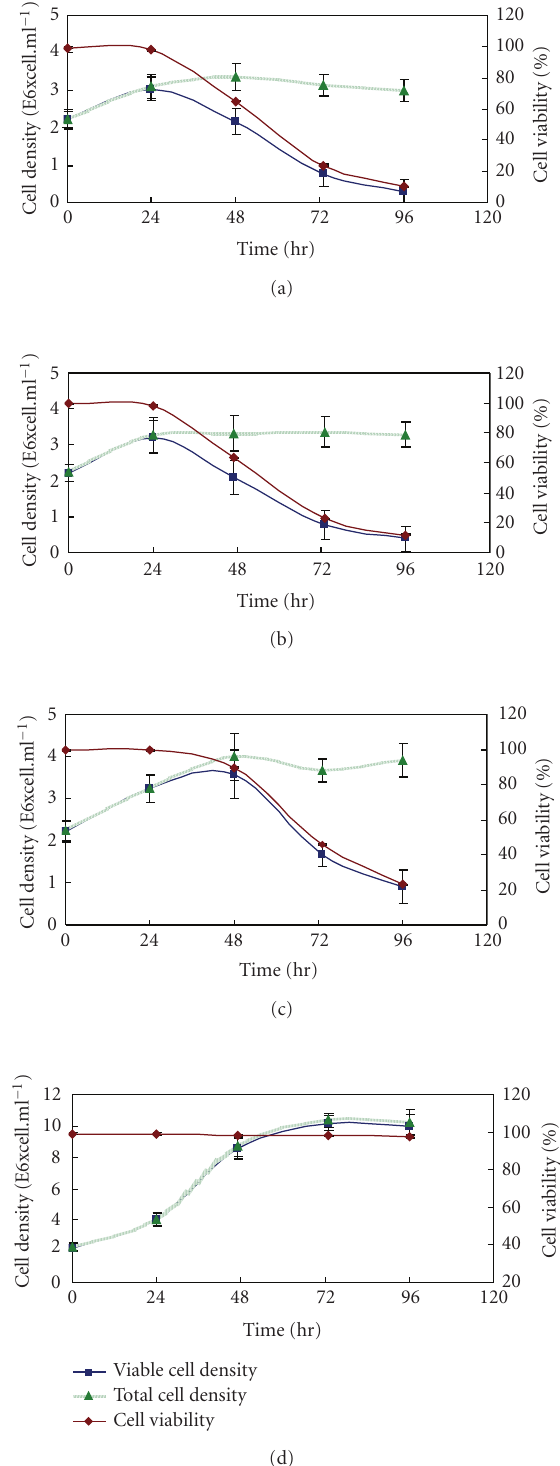
Figure 7: Viable cell density, total cell density and viability of the Sf9 insect cells infected with di ff erent MOI of rbacmid/hIL-7. Di ff erent multiplicity of infection (MOI) between 5 to 0.5 was used. Sf9 cells were cultured in shaker flasks and incubated at 27 ◦ C with agitation at 115 rpm. Samples were taken at regular intervals (24, 48, 72, and 96) hpi. (a), (b), (c) Infected cells with MOI:5, 1 and 0.5 of the virus stock, respectively. (d) Control (Noninfected insect cells) ( n =